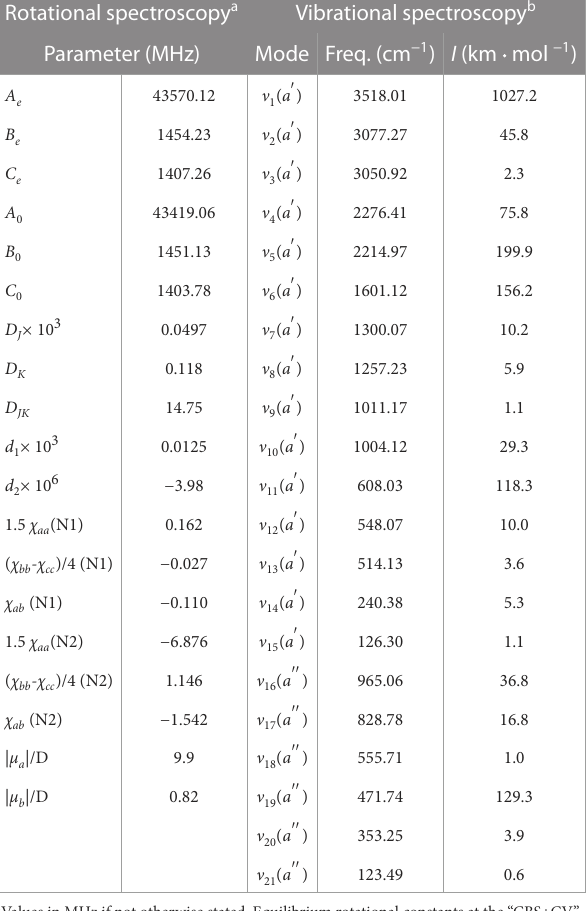
TABLE5 Computedspectroscopicparametersof( E )-NCCHCHCNH +